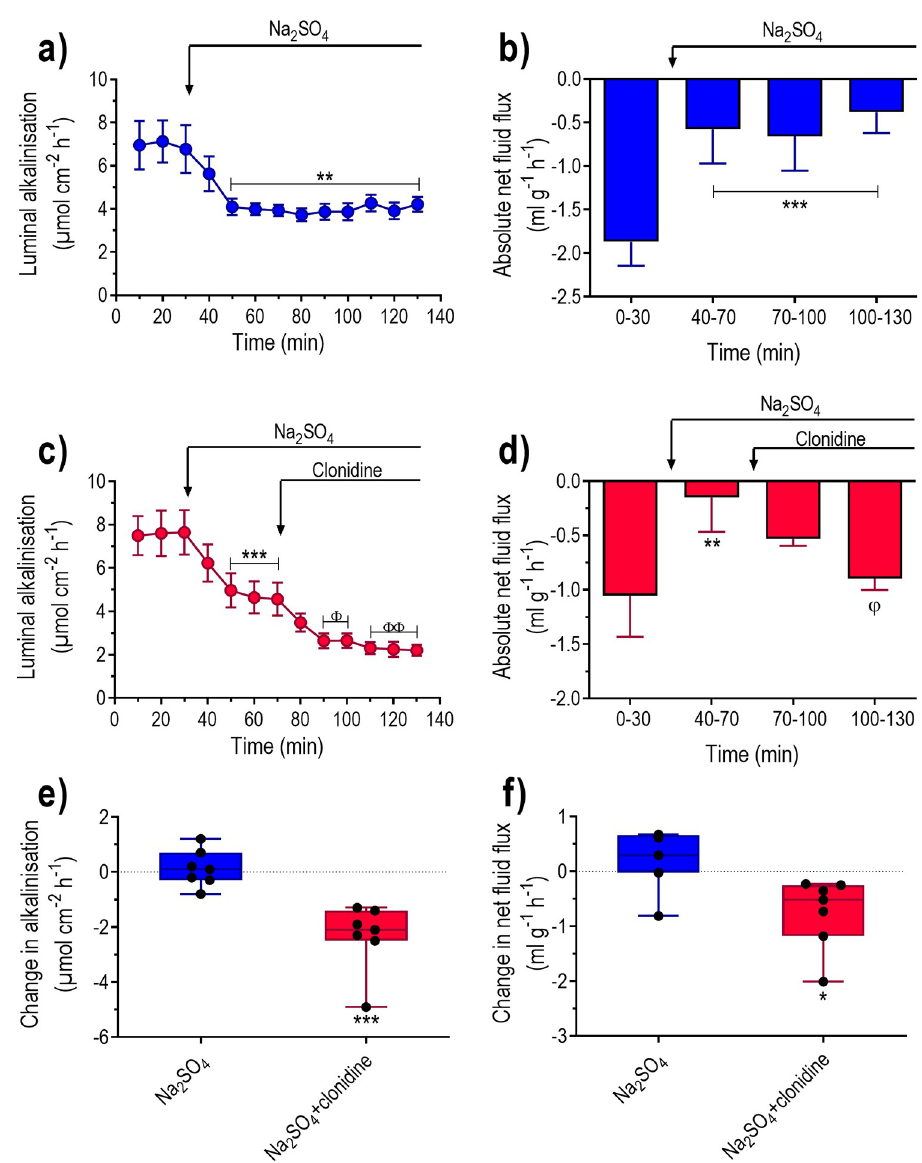
Fig 3. The effects clonidine on net fluid flux and luminal alkalinisation in rat duodenum perfused with an isotonic Cl - -free solution. Duodenum was perfused with isotonic saline for 30 min and subsequently with an isotonic Cl - -free Na 2 SO 4 solution for 100 min (Fig 1). Effects on luminal alkalinisation (a and c) and transepithelial net fluid flux (b and d) in the absence and presence of i.v. infusion of clonidine at a dose of 10 μ g kg -1 h -1 . Net changes in (e) luminal alkalinisation and (f) transepithelial net fluid flux between 110–130 min and 50–70 min (Na 2 SO 4 plus clonidine vs. Na 2 SO 4 alone). Values are means ± SEM or box plots with all individual points. � P < 0.05, �� P < 0.01 and ��� P < 0.001 compared with basal values. F P < 0.05 and FF P < 0.01 compared with values at 40–70 min. Fig (e) and (f); � P < 0.05 and ��� P < 0.001 compared with values in animals treated with Na 2 SO 4